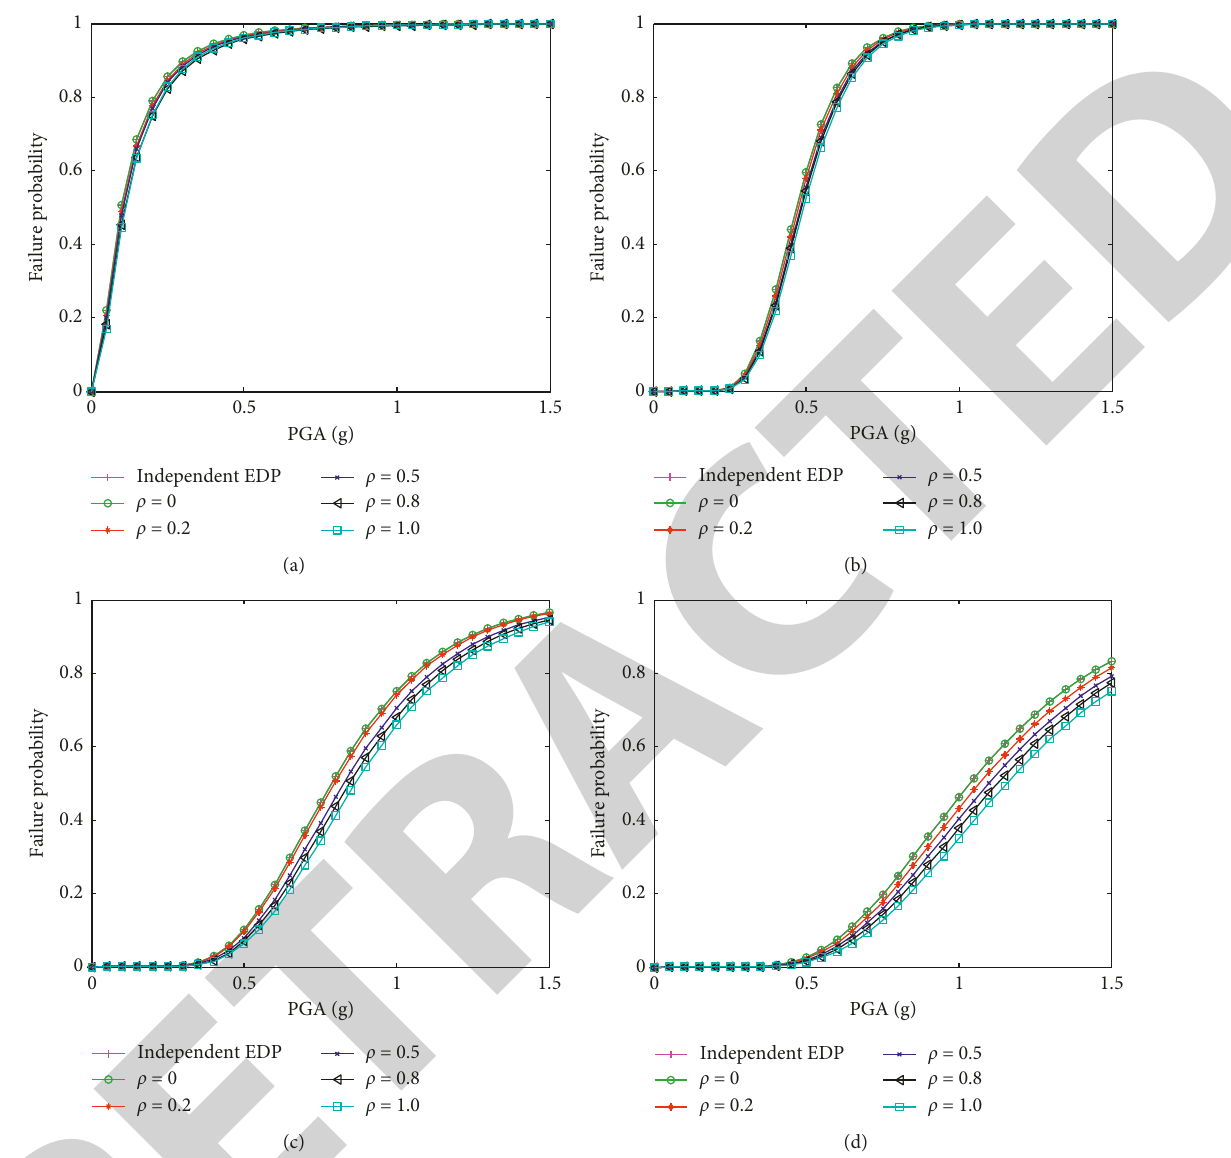
Figure 7: Sensitivity analysis of multidimensional fragility curves to EDP correlation. (a) Normal operation PLS. (b) Immediate occupancy PLS. (c) Life safety PLS. (d) Collapse prevention